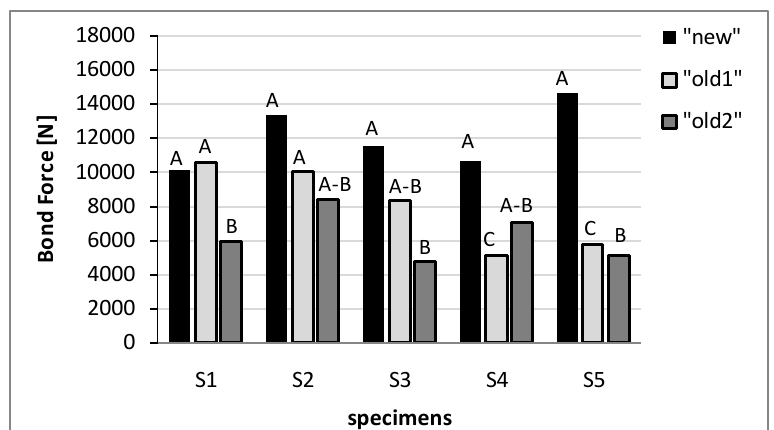
Figure 7. Bond resistance and detachment mechanism.